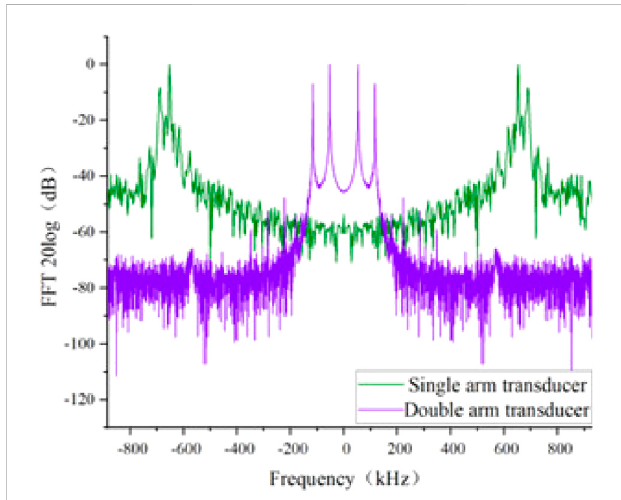
FIGURE 2 Comparison ofFFT frequencybands ofdouble-arm and1/4 single- arm vibration.